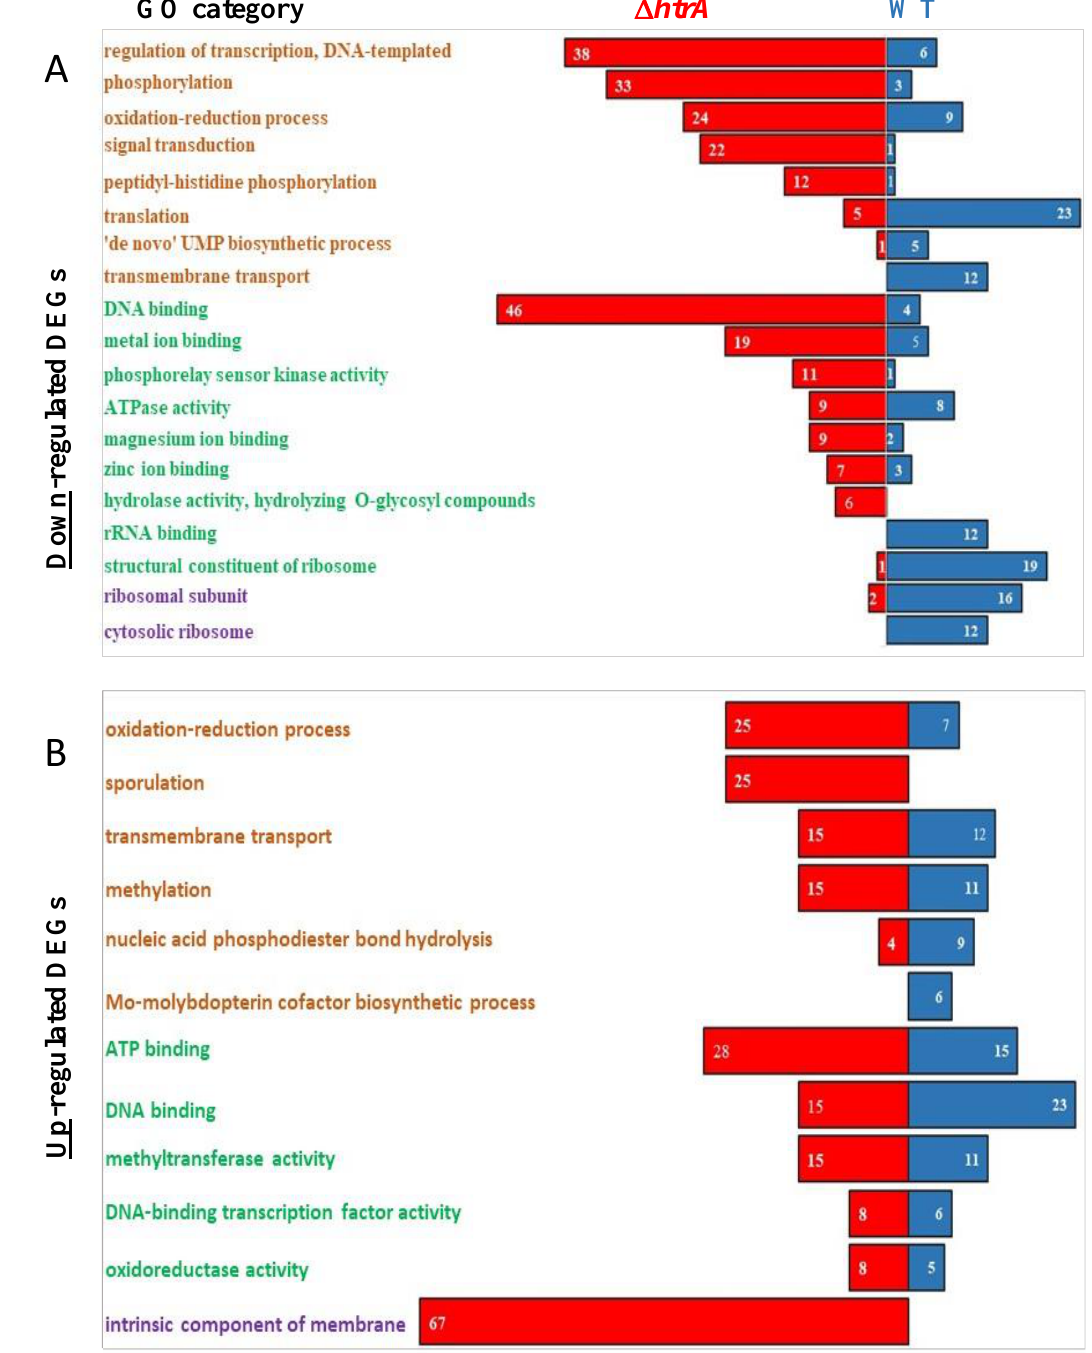
Figure 4. Gene Ontology (GO) analysis of downregulated ( A ) and upregulated ( B ) DEGs upon H 2 O 2 . ( A ). Inherent to the GO enrichment analysis, one particular gene may belong to more than one GO category. For the GO analysis, an adjusted p value of < 0.05 was